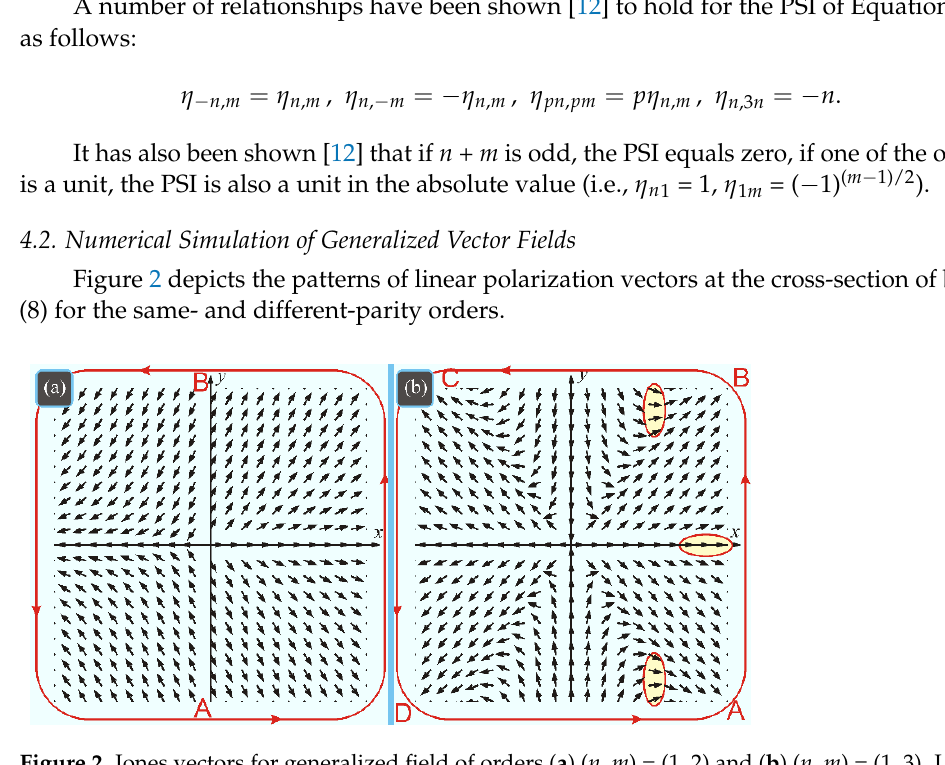
Figure 2. Jones vectors for generalized field of orders ( a ) ( n , m ) = (1, 2) and ( b ) ( n , m ) = (1, 3). Letters A, B, C, and D mark segment boundaries for a contour along which the field vector tilt to the x -axis increases or decreases. The ellipses show the areas with the horizontal polarization (rightwards).